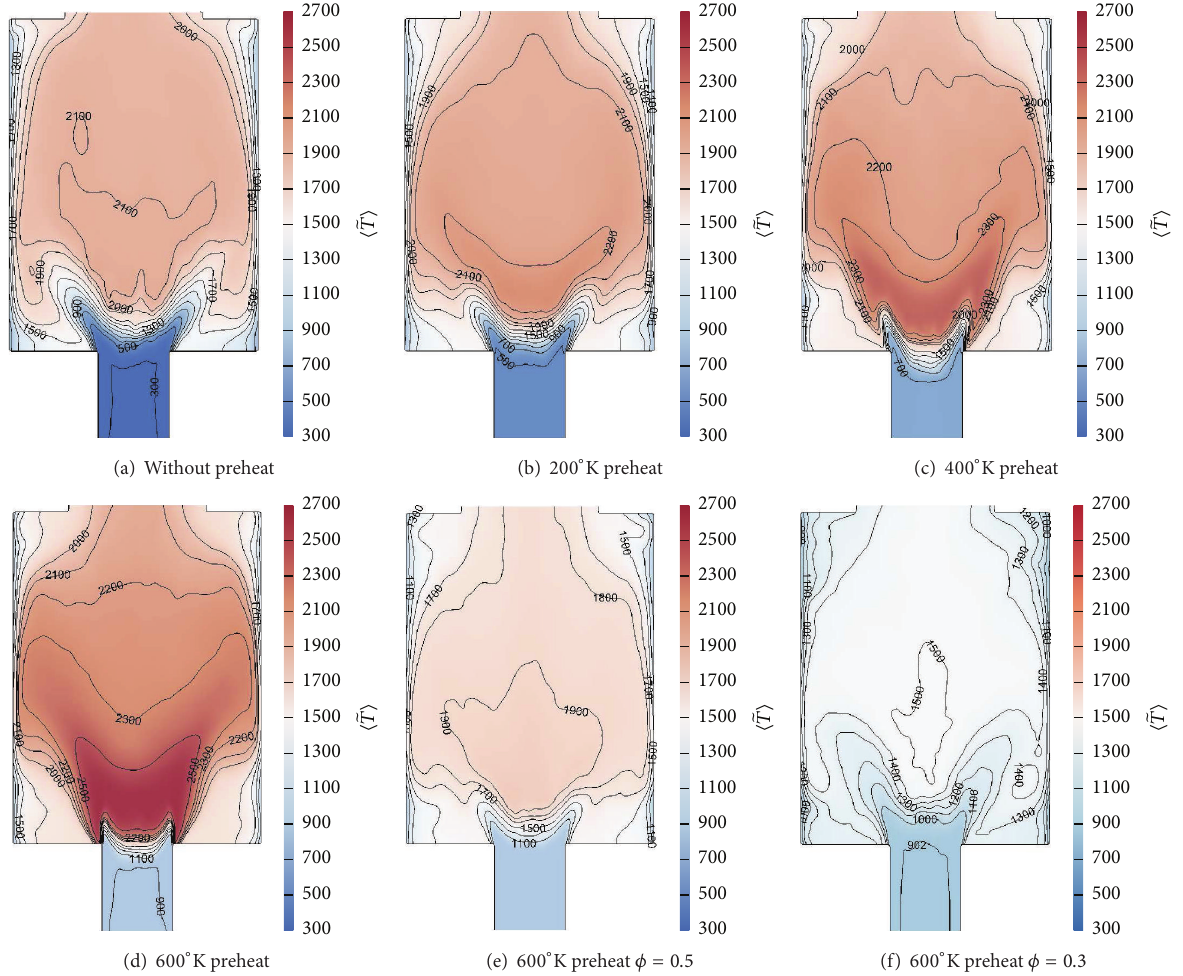
Figure 5: Mean temperature contours across the center of the